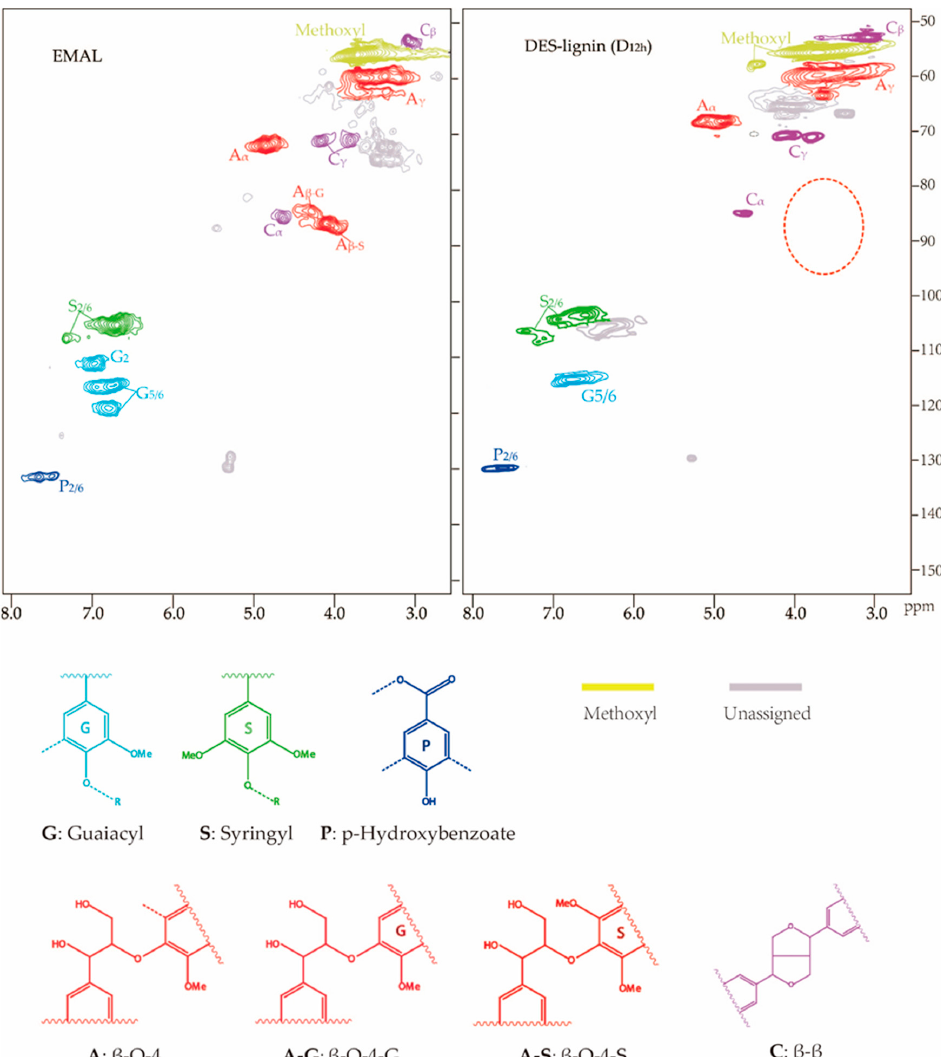
Figure 4. 2D-HSQC NMR analysis of DES-lignin sample (D 12h ) extracted from willow by DES treatment at 120 °C for 12 h and the EMAL extracted from willow by enzymatic/mild acid hydrolysis treatment.